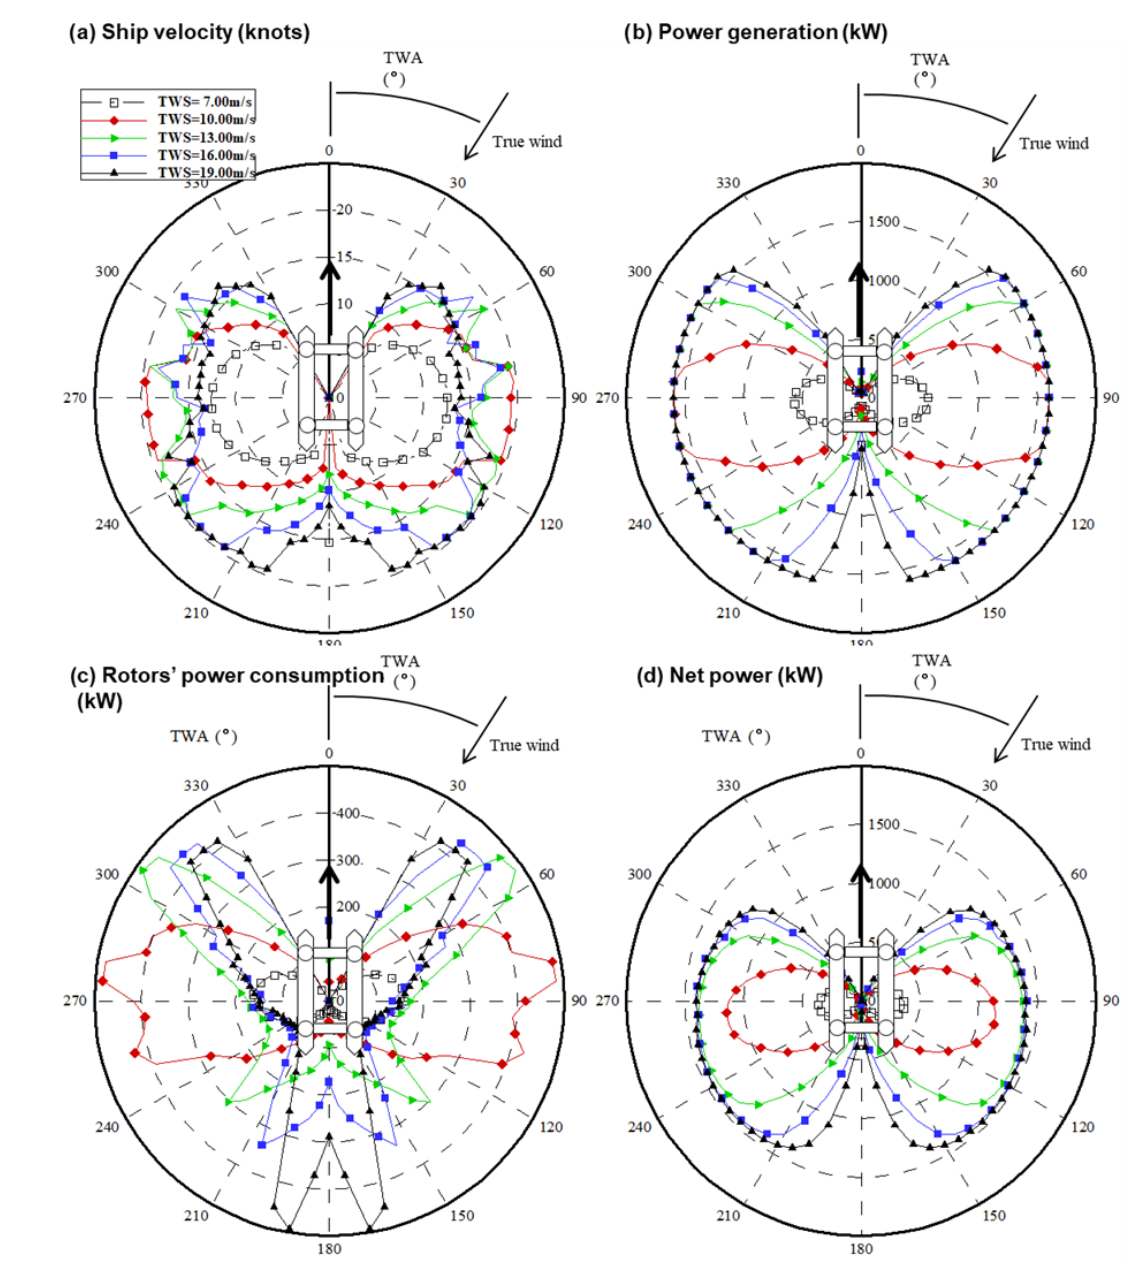
Figure 6. Ship velocity (a) , power generation (b) , rotors’ power consumption (c) and net power (d) of the updated ship design as function of wind conditions. TWA stands for true wind